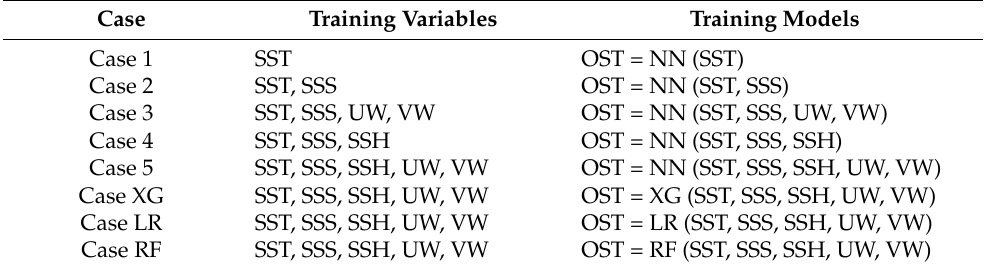
Figure 1. The flow chart of the estimated OST in the western Pacific Ocean. Table 2. Design of experiments.